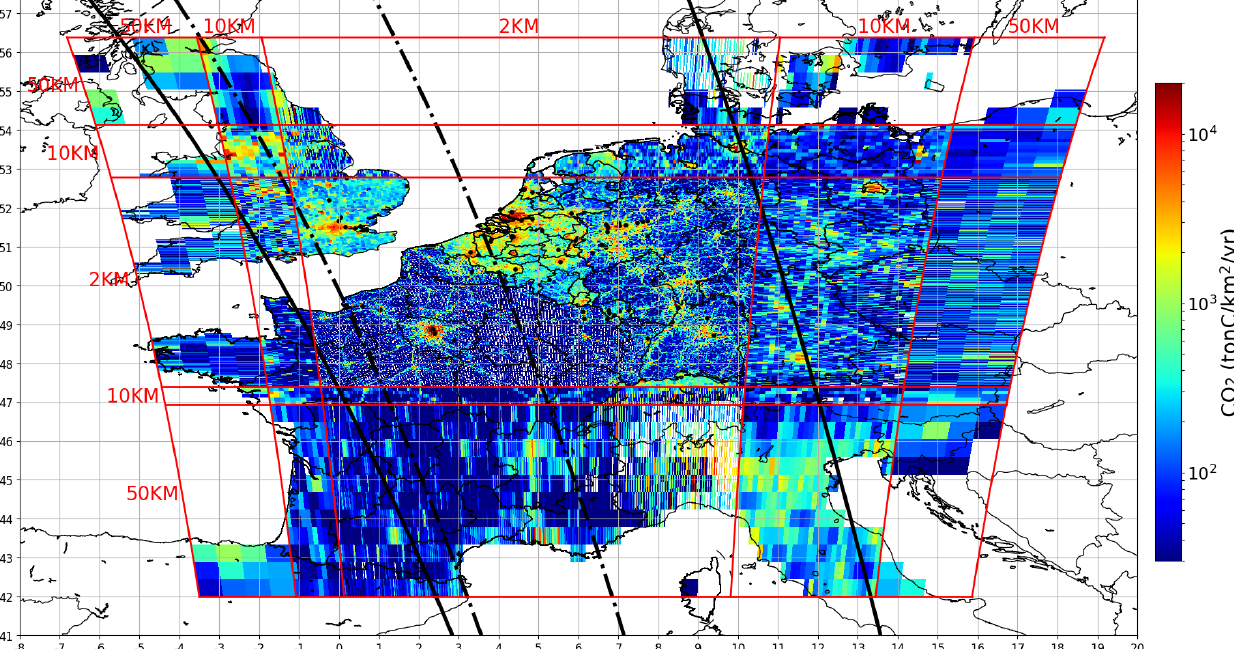
Figure 1. Maps of the IER annual emissions interpolated over the domain of the CHIMERE model. Point sources are indicated by black dots, and administrative regions are shown using thin black lines. The grid of the model is defined by subdomains with several resolutions ( r × s km 2 , where r and s are 2, 10 or 50km), and their boundaries are represented by the red lines. The thick black lines depict the edges of the satellite tracks corresponding to the synthetic data used in this study (300km swath: dash-dotted line; 900km swath: solid